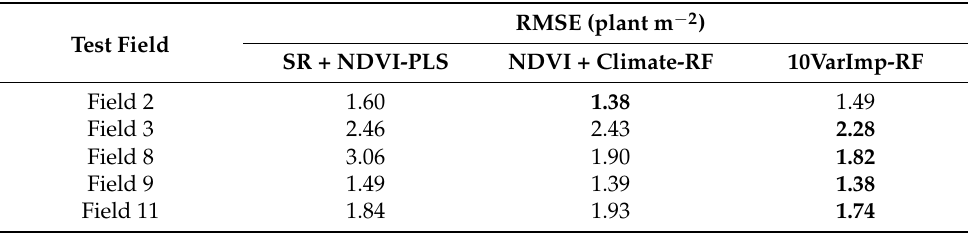
Figure 11. Residual maps for ( a ) SR + NDVI-PLS; ( b ) NDVI + Climate-RF; and ( c ) 10VarImp-RF models compared to actual plant density data derived from YOLOv3 model. Table 4. RMSE values for individual fields using three different regression model (SR + NDVI-PLS; NDVI + Climate-RF;